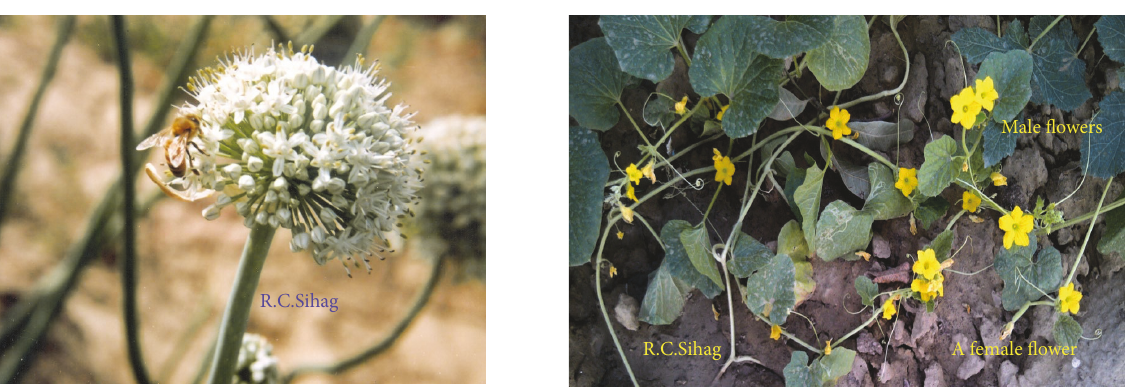
Figure 6: Malebiased sex ratio in the flowers of a cucurbitplant; the probability of visit of a pollinator to the female flower will depend upon this